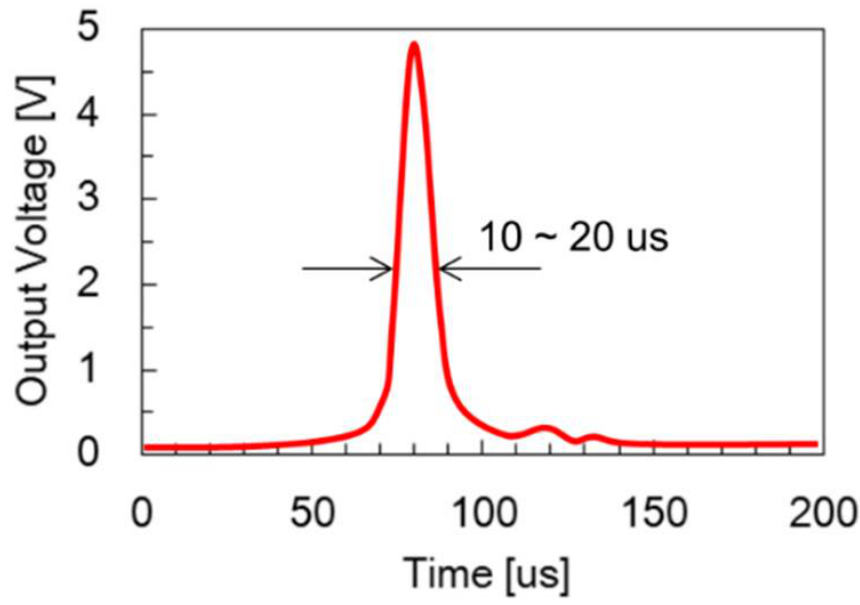
Figure 2. Waveform of pulse voltage obtained from a Wiegand sensor.